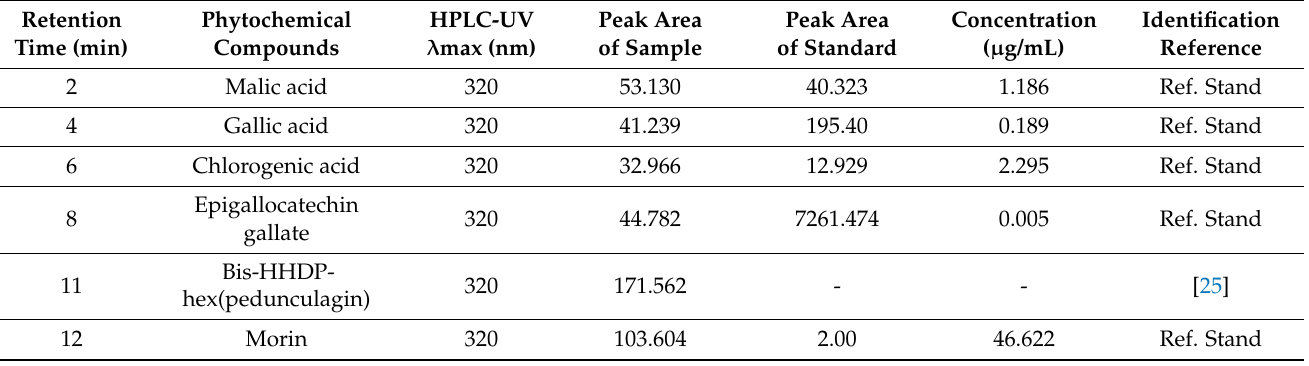
Figure 4. HPLC chromatograms of crude extract ( A ), various purified fractions ( B – E ), and n -hexane fraction ( F ) of A. articulata . Table 2. Identified phytochemicals in crude extract of A. articulata through the HPLC-UV